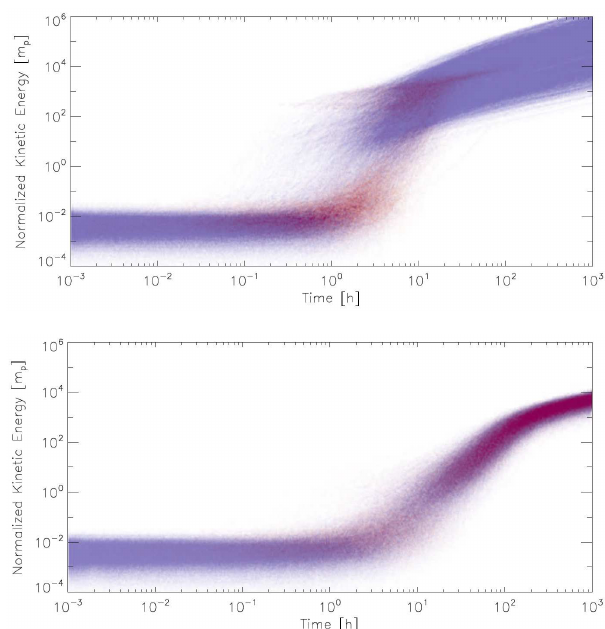
Fig. 7. Top panel: kinetic energy evolution in time of 10000 pro- Fig. 7. Top panel : kinetic energy evolution in time of 10,000 pro- tons in a 2-D model of reconnection (i.e. with magnetic field on a tons in a 2D model of reconnection (i.e. with magnetic field on a plane). Bottom panel: the same distribution but in a fully 3-D model plane). Bottom panel : the same distribution but in a fully 3D model of reconnection. In 2-D the perpendicular component of particle ve- of reconnection. In 2D the perpendicular component of particle ve- locities (in blue) becomes dominant over time with respect to the locities (in blue) becomes dominant over time with respect to the parallel component (in red). While in a 3-D domain it is the parallel parallel component (in red). While in a 3D domain it is the parallel component to dominate. The energy is normalized to the proton rest component to dominate. The energy is normalized to the proton rest mass. The background magnetized flow with multiple current sheet mass. The background magnetized flow with multiple current sheet layers is at time 4.0 in Alfv´en time units in the model. Note that layers is at time 4.0 in Alfv´en time units in the model. Note that the transition from exponential energy grow to nearly linear occurs the transition from exponential energy grow to nearly linear occurs when the largest loop in the plasma reaches the size of a few tens when the largest loop in the plasma reaches the size of a few tens the size of simulation box. From Kowal et al. the size of simulation box. From Kowal et al. (2011).